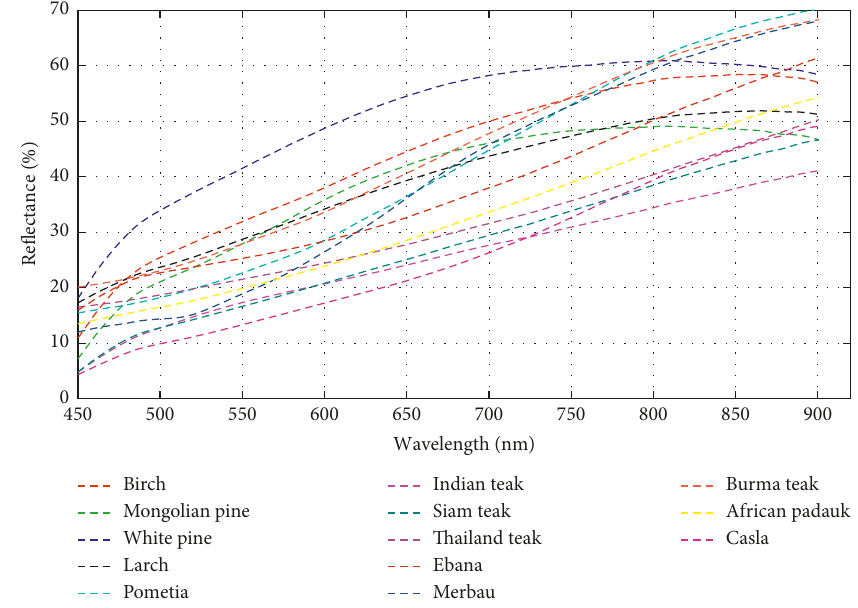
Figure 3: Spectral curve graph of our 13 wood species. Table 3: One-class classification of SVDD with optimal parameters and